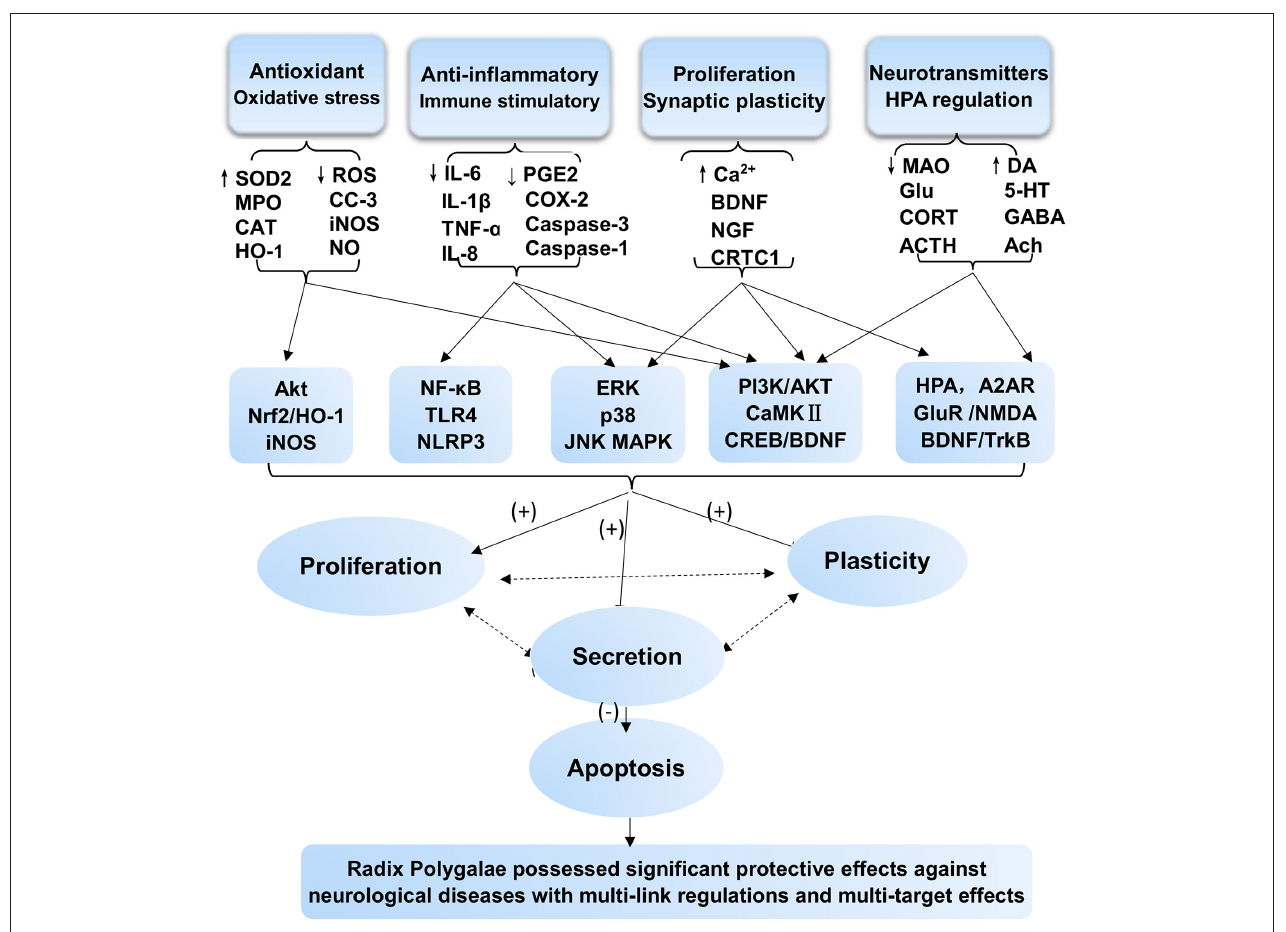
FIGURE 3 | Protective effects and mechanism network analysis of RP against CNS neurological and psychotic diseases in vitro and in vivo with multiple links across regulatory mechanisms and multitarget effects. Minus sign (–) stands for downregulation or inhibition; plus sign ( + ) stands for upregulation or activation; question mark (?) stands for uncertainty or no